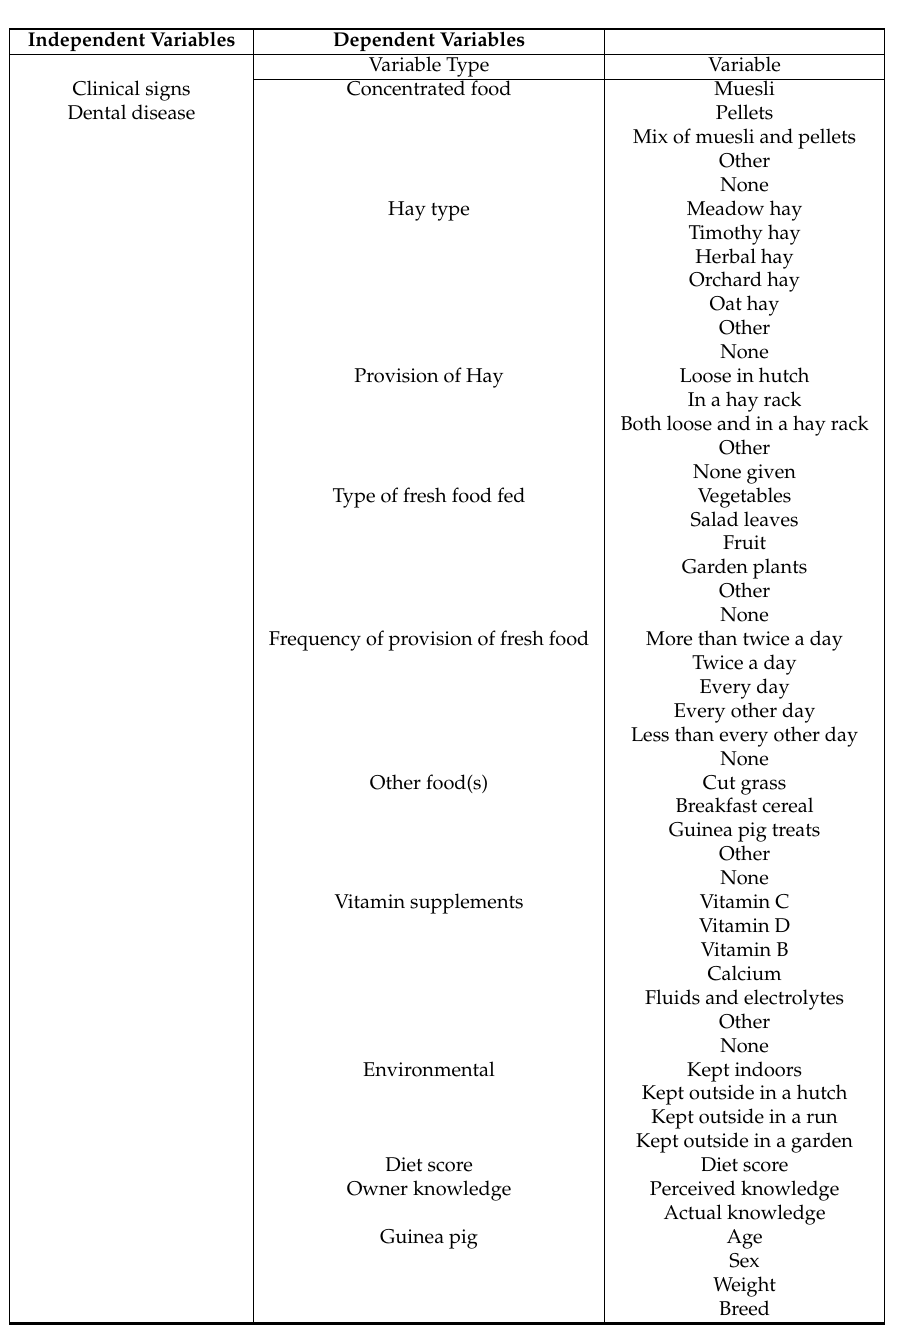
Table 1. Variables related to guinea pig diet and husbandry that were included in the binary logistic regression